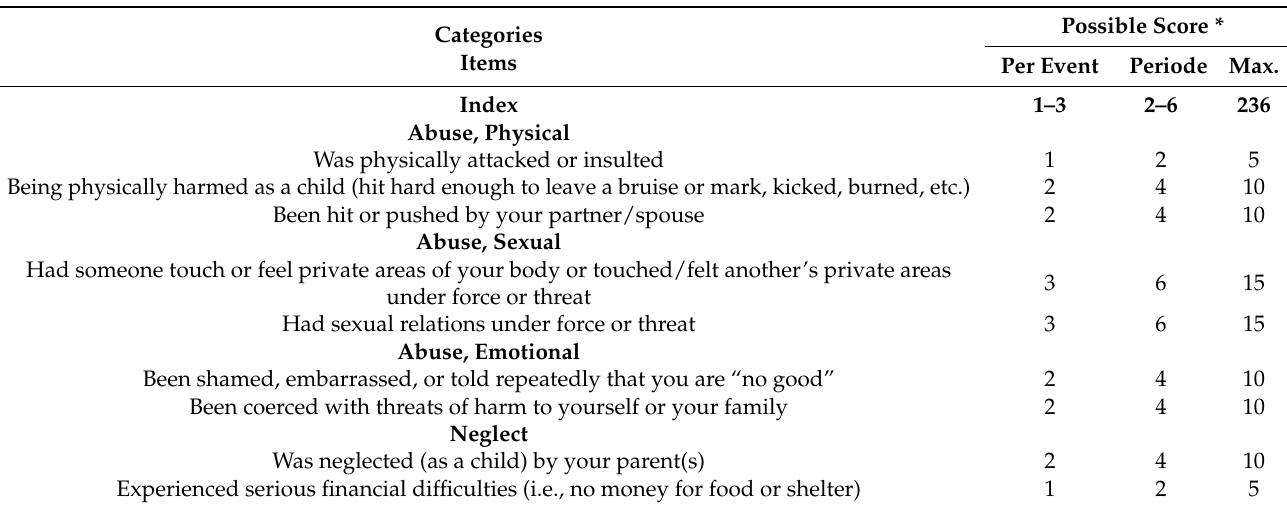
Table 4. Weighted Index for Childhood Adverse Conditions